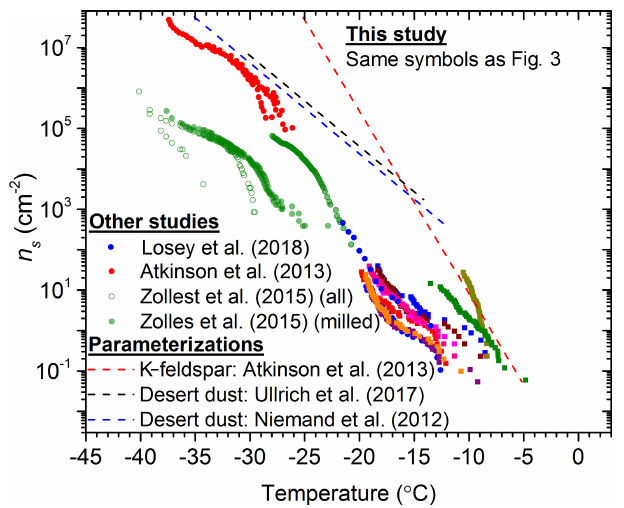
Figure 5. Plot of n s versus temperature for the available literature data for quartz compared to the data collected in this study. The symbols for this study’s data are displayed the same as in Fig. 2 and only the first runs (fresh samples) from this study are plotted. The data from Zolles et al. (2015) have been split into quartz samples that were milled for fresh surfaces and all the combined data (both milled and unmilled quartz).